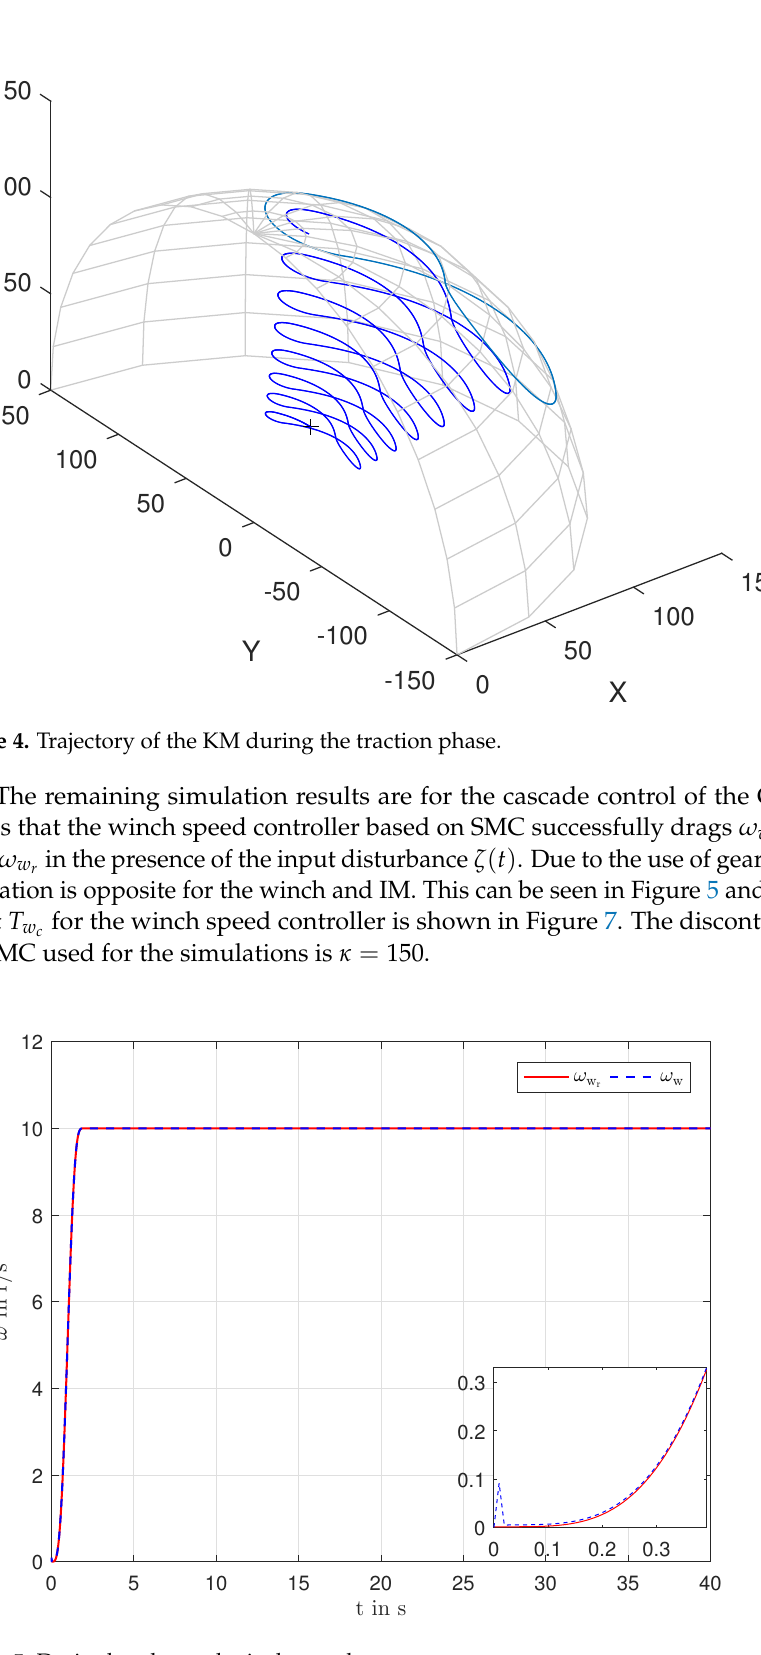
Figure 5. Desired and actual winch